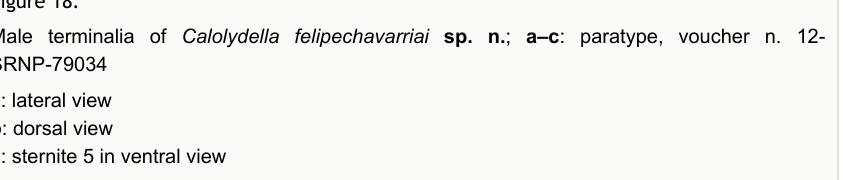
Female (Fig. 17d, e, f). Length: 4–5mm. Fronto-orbital plate 1.36X as wide as in male. Diagnosis